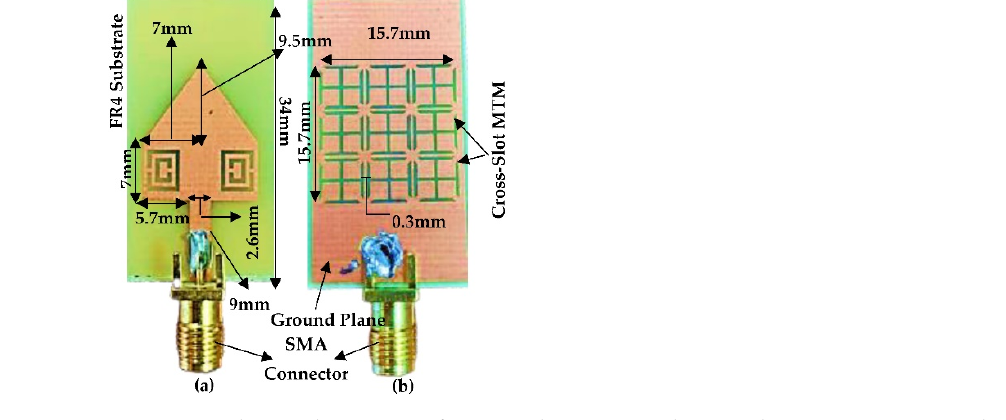
Figure 15. Fabricated structure of proposed antenna with cross-slot MTM structure etched on the ground plane ( a ) Top Layer ( b ) Bottom Layer.